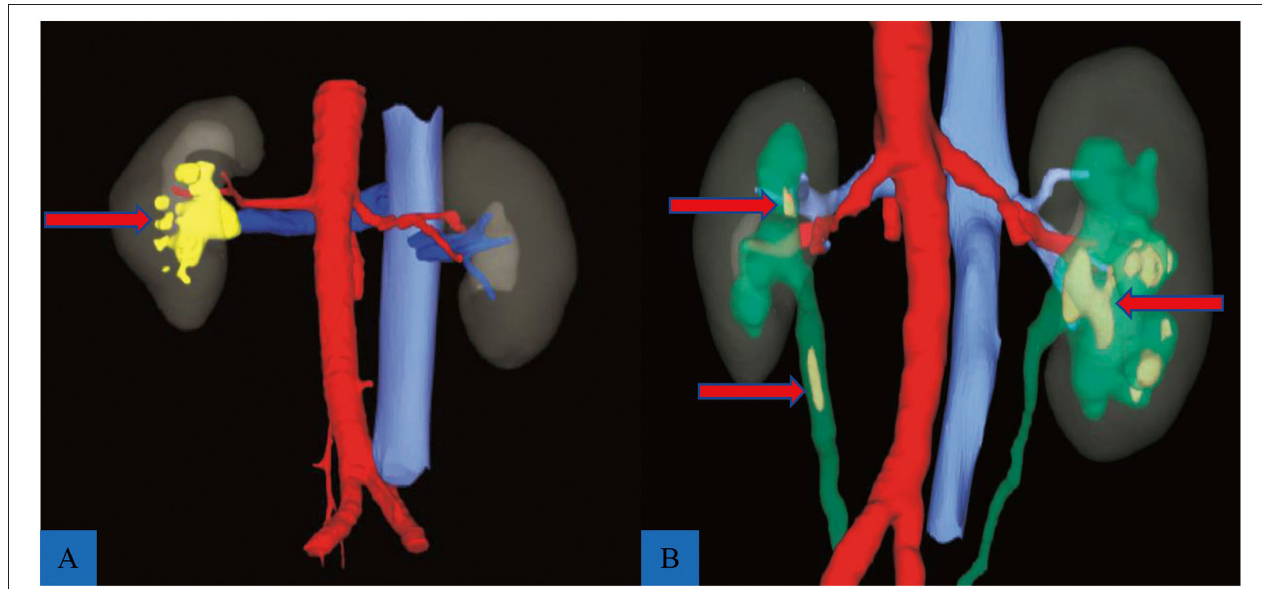
FIGURE 1 | Reconstructed models of two complex renal calculi cases. (A) A staghorn stone (red arrow) located in the right kidney; red indicates artery, blue shows vein, and yellow indicates stone. (B) Multiple renal calculi (red arrow) complicated with ureteral calculi (red arrow); green shows renal pelvis and